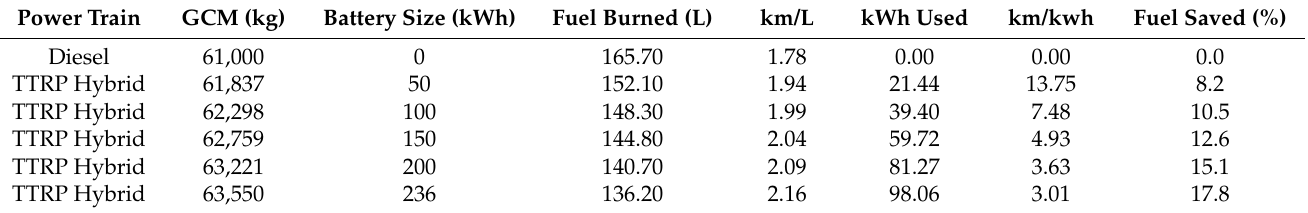
Table 9. Drive cycle 4 results.